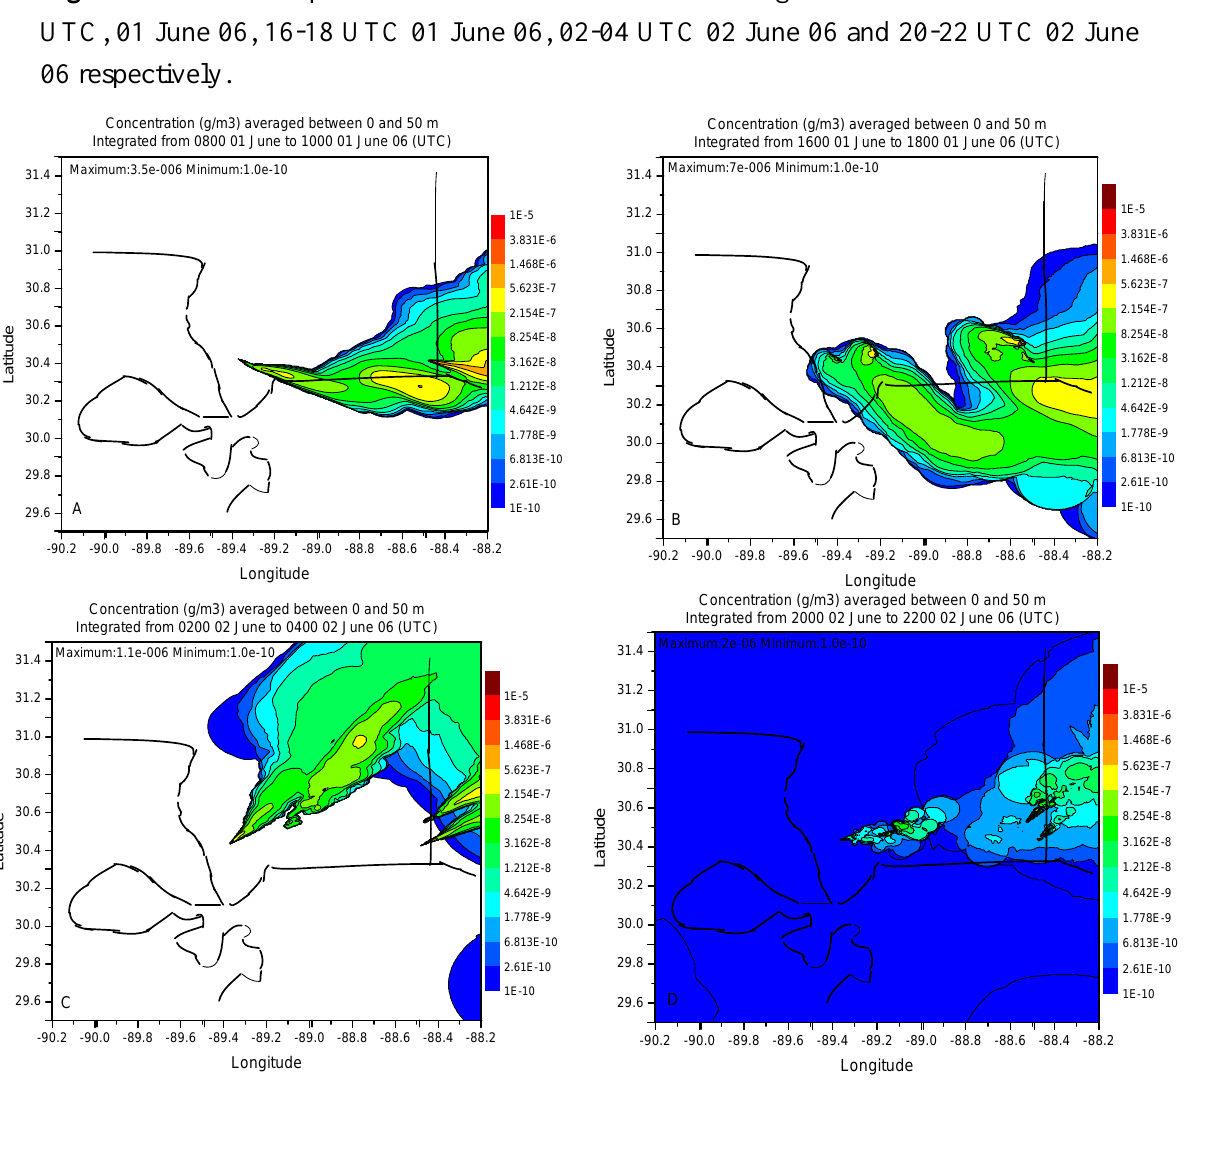
Figure 9. Simulated plume concentration distribution using WRF model data at 08-10 UTC, 01 June 06, 16-18 UTC 01 June 06, 02-04 UTC 02 June 06 and 20-22 UTC 02 June 06 respectively.